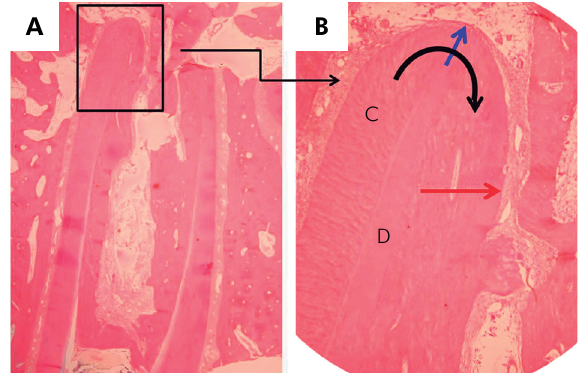
Figure 4. (A) Photomicrograph of a specimen from the triple antibiotic paste group (20× magnification). (B) Detail of the area shown in A, evidencing cementum-like mineralized tissue formation, responsible for increased thickness (red arrow) and greater apical extension (blue arrow) of root. Note ingrowth of cementum from the external into the internal radicular surface (black arrow). C: Cementum; D: